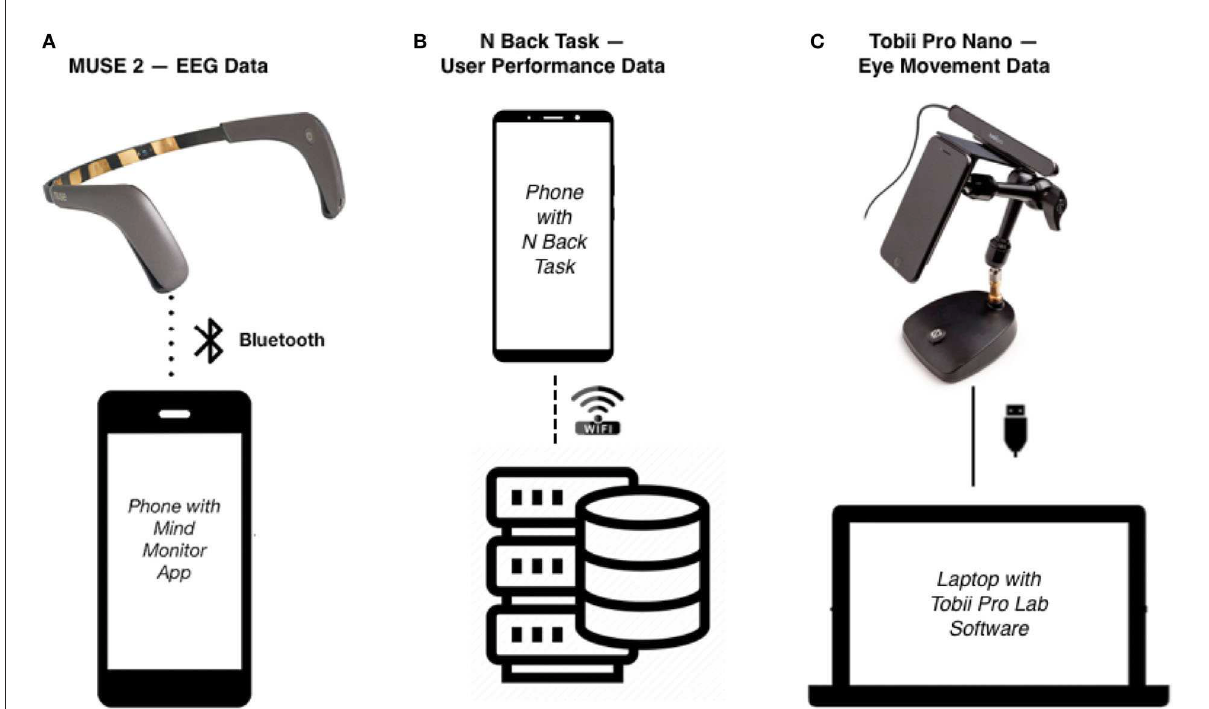
FIGURE4 (A) The MUSE 2 headband was transmitted over Bluetooth to a phone via an application called Mind Monitor for EEG data collection, and the EEG data were uploaded to the research’s selected cloud drive after each participant completed the task. (B) The N back task was recorded on a website designed by researchers, and the user performance data were collected via the server. (C) The Tobii Pro Nano eye tracker was connected to a laptop with Tobii Pro Lab software installed, and the eye movement data were collected by the Tobii Pro Lab software and stored in the hard drive of the